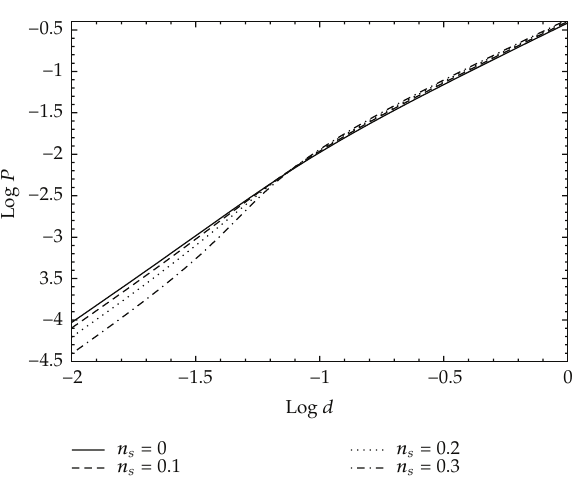
Figure 6: Pressure versus density of the multiquark phase in logarithmic scale at T (cid:8) 0 . 03, zoomed in around the transition